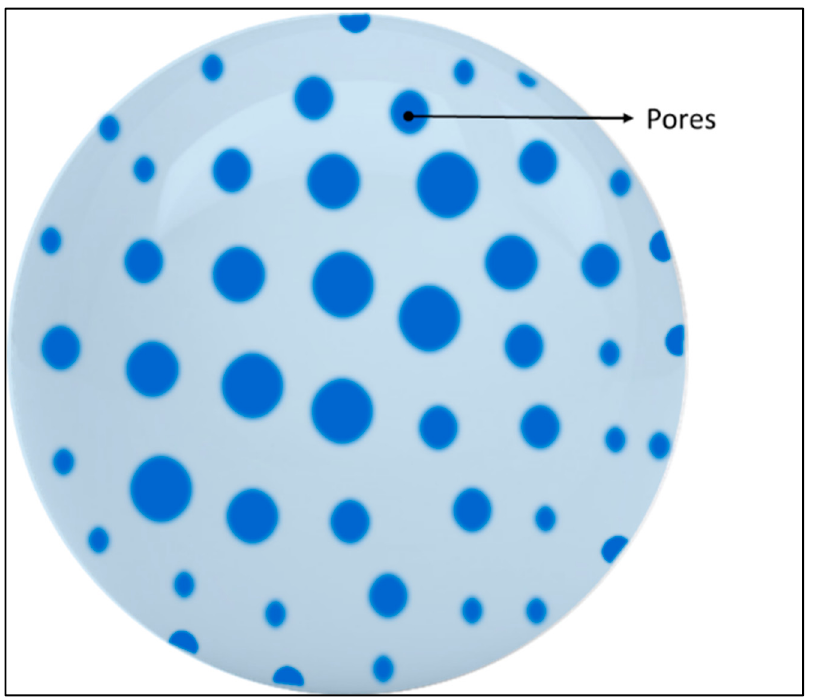
Figure 9. Mesoporous silica nanoparticles structure represented by a blue sphere and the darker small circles shows the pores present on its surface.